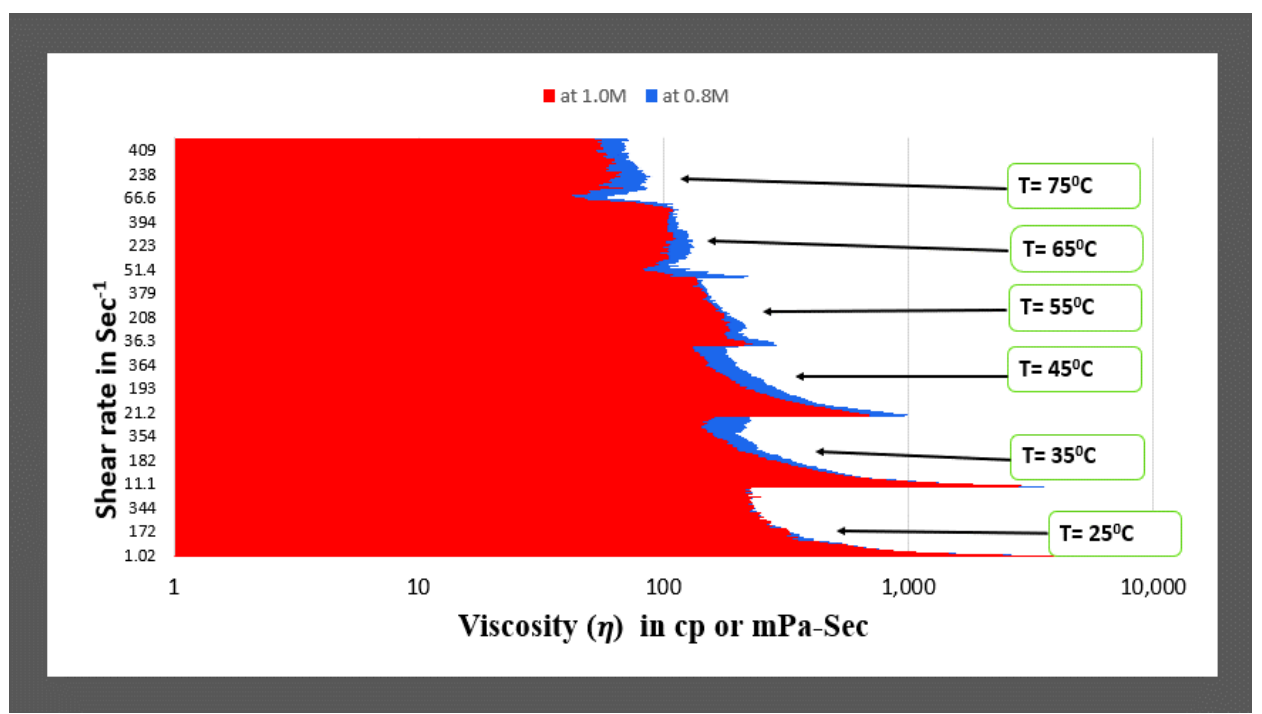
Figure 5. Comparison of viscosity plot of type1 viscoelastic fluids containing 0.8 M and 1.0 M NaNO 3 concentration at different temperatures.